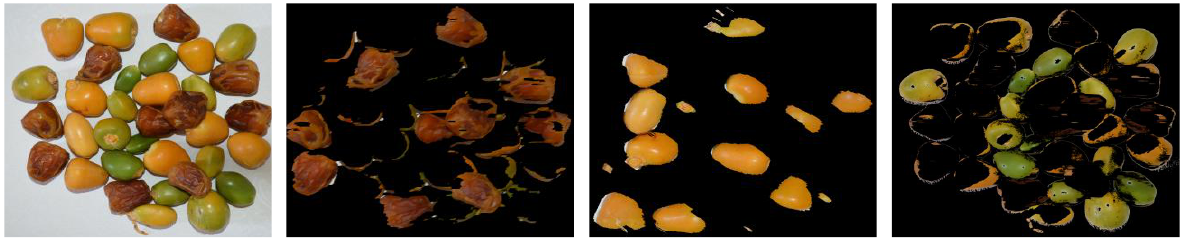
Figure 5. Segmentation and classification of dates